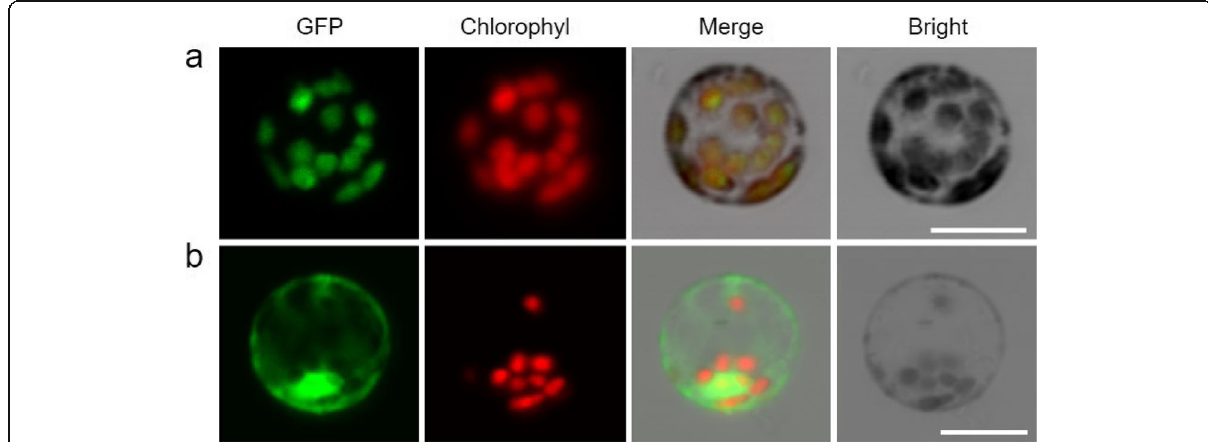
Fig. 6 Subcellular localization of OsGSAM protein. a GFP signals of the OsGSAM-eGFP fusion protein. b Empty vector eGFP without a specific targeting sequence. Green fluorescence shows GFP, red fluorescence indicates chloroplast autofluorescence, yellow fluorescence indicates images with the two types of fluorescence merged, and bright field images shows rice protoplasts. Fluorescence signals were visualized using a laser- scanning confocal microscopy. Bars = 10 μ